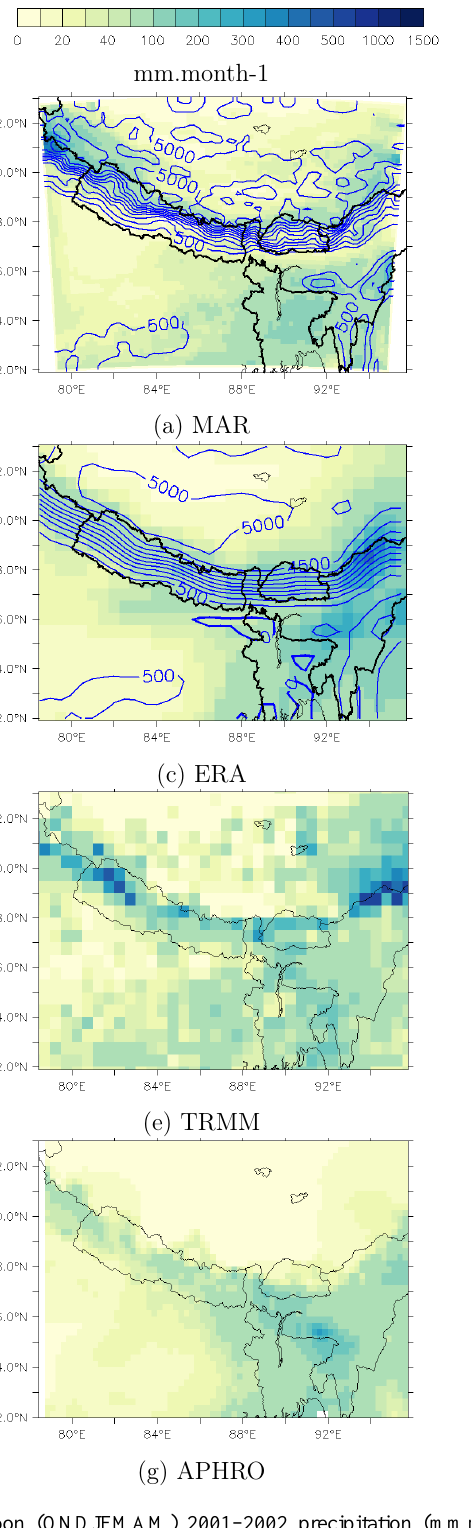
Fig. 4. Extra-monsoon (ONDJFMAM) 2001–2002 precipitation (mmmonth − 1 ): (a) simulated with MAR, (c) estimated from ERA- INTERIM, (e) evaluated from TRMM, and (g) observed with APHRODITE network. Figures in the right column correspond to the dif- ferences (b) MAR-APHRODITE, (d) ERA-INTERIM-APHRODITE, (f) TRMM-APHRODITE, and (h)